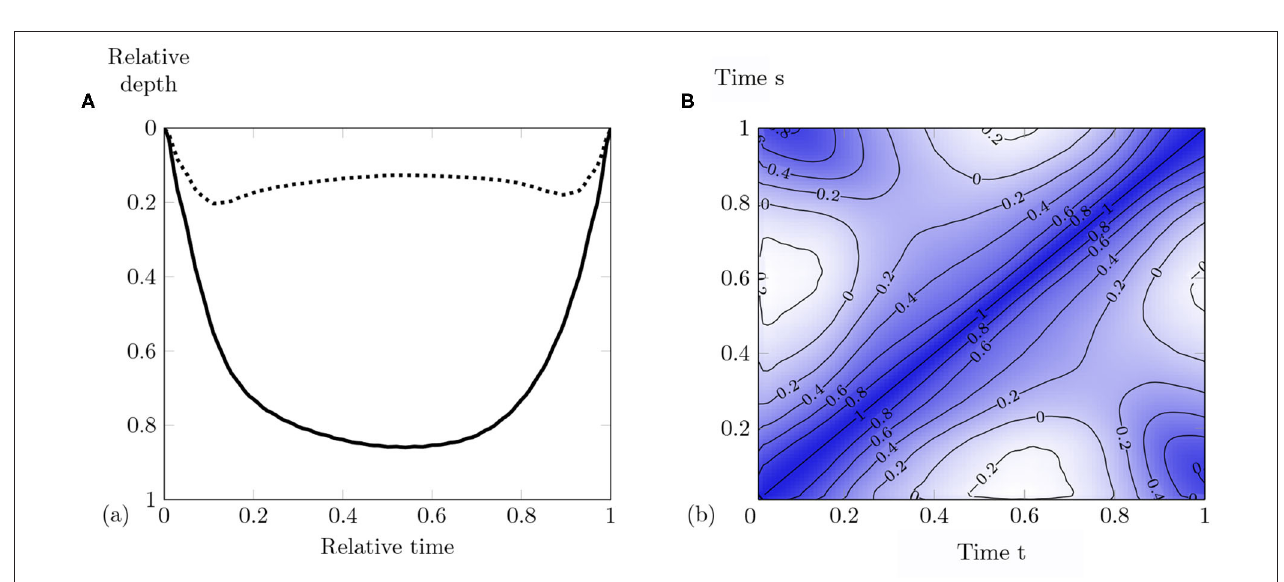
FIGURE 7 | (A) Mean dive (solid curve) and standard deviation function (dotted curve). (B) Contour plot of the correlation corr N ( t , s ) computed on the entire set of coefficients of the B-splines expansion of the normalized dives. This bivariate function is symmetrical as a correlation matrix. It shows the correlation of normalized dives for each couple of times ( t , s ). For example, the correlation between the beginning of dives ( s = 0.05) and dives at t = 0.6 is minimum ( − 0.25). Correlation scale from − 0.25 (white) to 1 (dark blue).